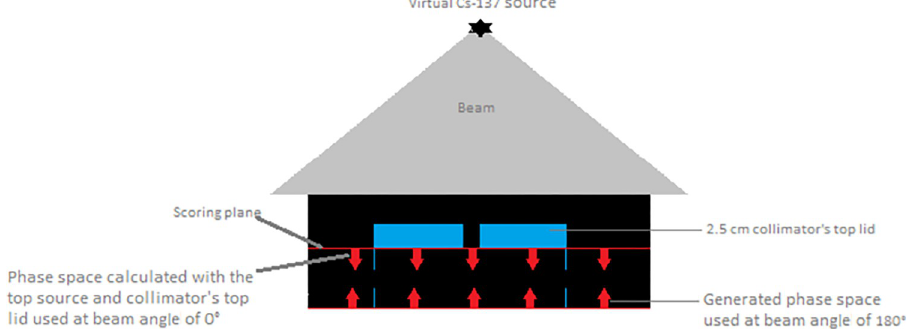
Fig 2. Illustration of MC modelling of the irradiation system. MC modelling of the 137 Cs source and collimator top lid are demonstrated using BEAMnrc components. The scoring surface is positioned right below the collimator’s lid (red line). The top and bottom red arrows represent the phase-space file used multi-directionally employed at beam angel of 0˚ and 180˚.